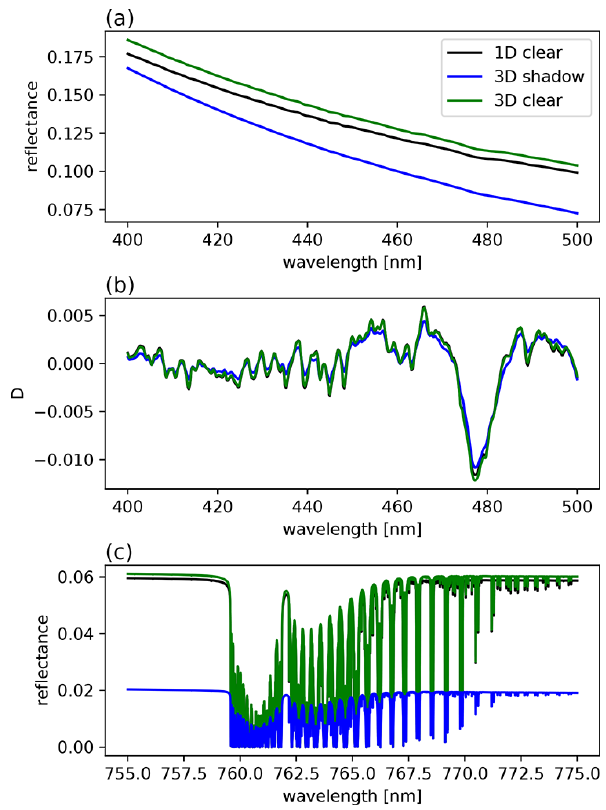
Figure 4. (a) Reflectance spectra for the spectral range from 400– 500nm and (b) differential optical thicknesses derived from these spectra. (c) Corresponding reflectance spectra in the O 2 A-band re- gion. The black lines correspond to a 1D clear-sky simulation and the blue and green lines to 3D simulations. The blue lines are for a pixel centred 1.5km away from the cloud edge in the cloud shadow, and the green lines are for a pixel centred 10.5km away from cloud edge in the clear